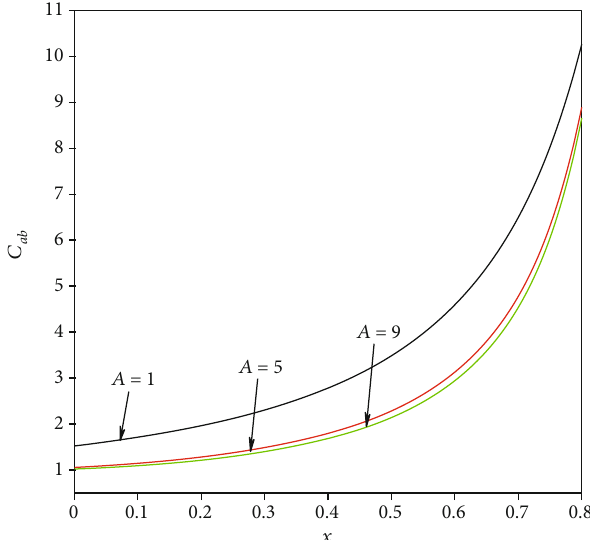
Figure 13: The steady state photon number correlation function of the two-mode cavity radiation versus x for κ = 0 : 5 , ε = 0 : 06 , C ab and di ff erent values of A